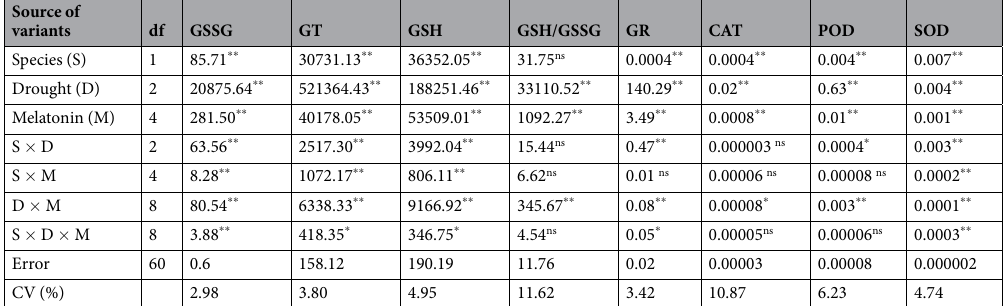
Table 2. Mean square values of the analysis of variance of oxidized glutathione (GSSG) (nmole g − 1 FW), total glutathione (GT) (nmole g − 1 FW), reduced glutathione (GSH) (nmole g − 1 FW), GSH/GSSG, Glutathione reductase (GR) ( µ mol min − 1 mg protein − 1 ), catalase (CAT) activity (U mg − 1 protein), peroxidase (POD) activity (U mg − 1 protein) and superoxide dismutase (SOD) and activity (U mg − 1 protein). * and ** : Significant at the 5% and 1% probability levels, respectively., ns : Non- Significant, according to the LSD multiple range test at P ≤ 0.05. df, degrees of